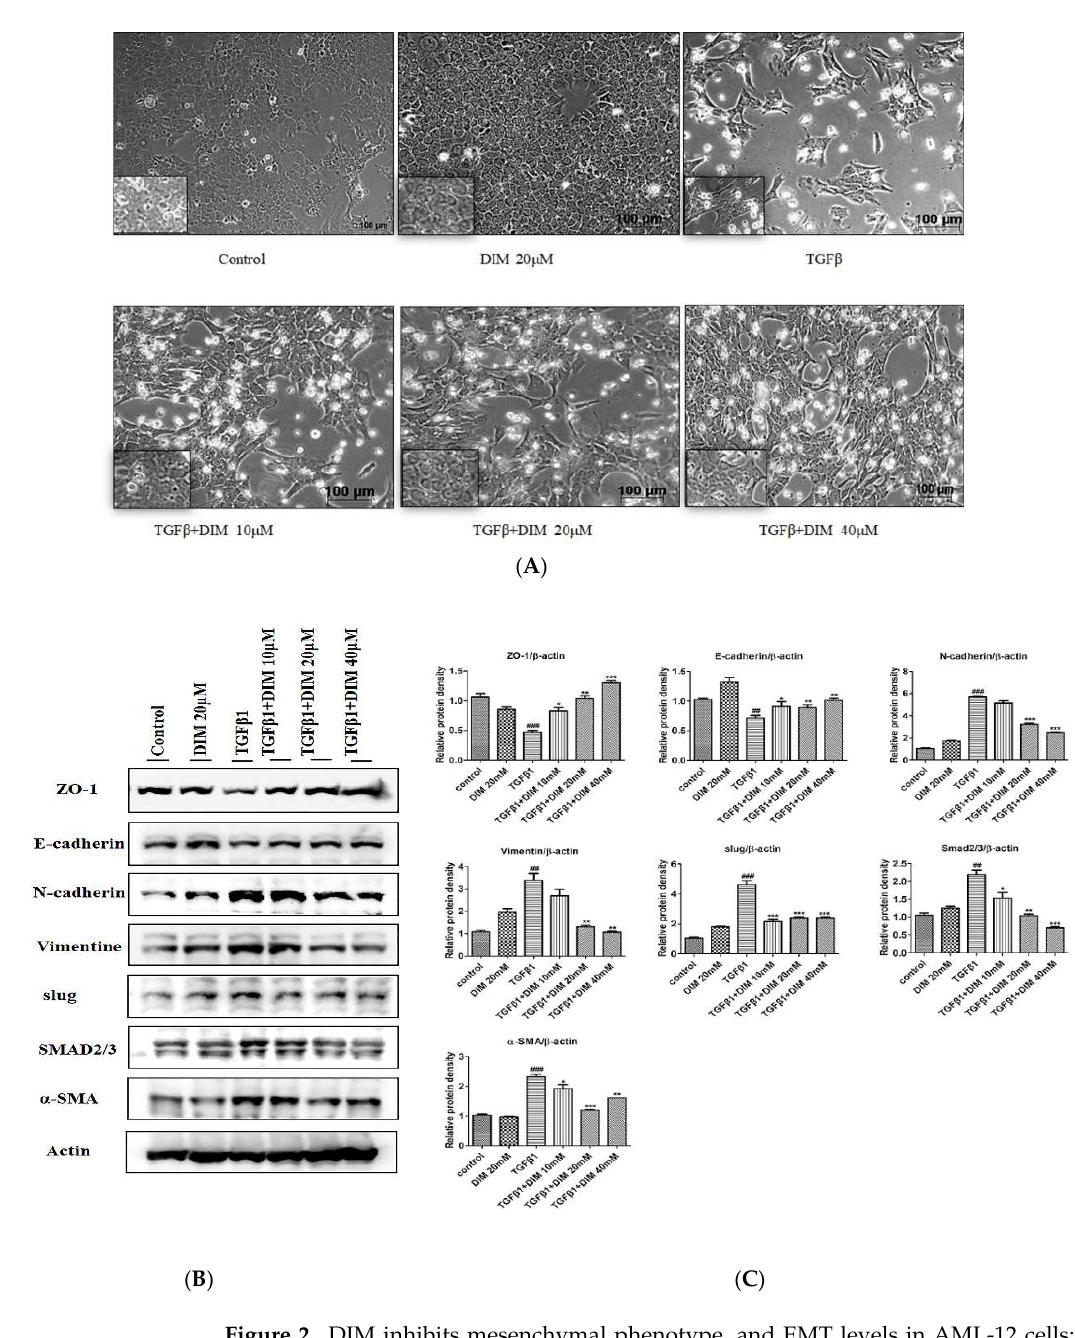
Figure 2. DIM inhibits mesenchymal phenotype, and EMT levels in AML-12 cells: ( A ) Pictures captured at 100× and 200× magnifications under a phase contrast microscope. ( C ) Western blot analysis determining the effect of DIM on protein expression of EMT-associated markers at 24 h after TGF-β1 treatment. ( B ) Quantitative analysis of relative protein expression normalized against β-actin. Data are presented as mean ± SE from three separate experiments ( n = 3). ## , p < 0.01 and ### , p < 0.001 denote significant differences compared to the control; * p < 0.05, ** p < 0.01, and *** p < 0.001 compared to treatment with TGF-β1 only.